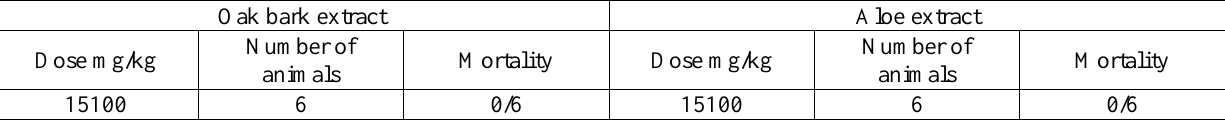
Study of acute toxicity of components of a new gel: oak and aloe extract in terms of intragastric administration to rats Oak bark extract Aloe extract Dose mg/kg